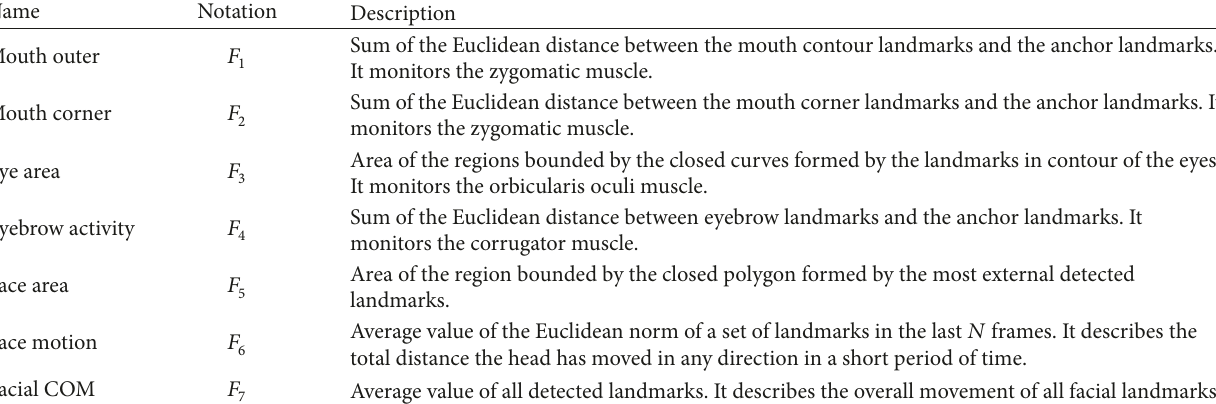
Table 1: Information regarding calculated facial features.